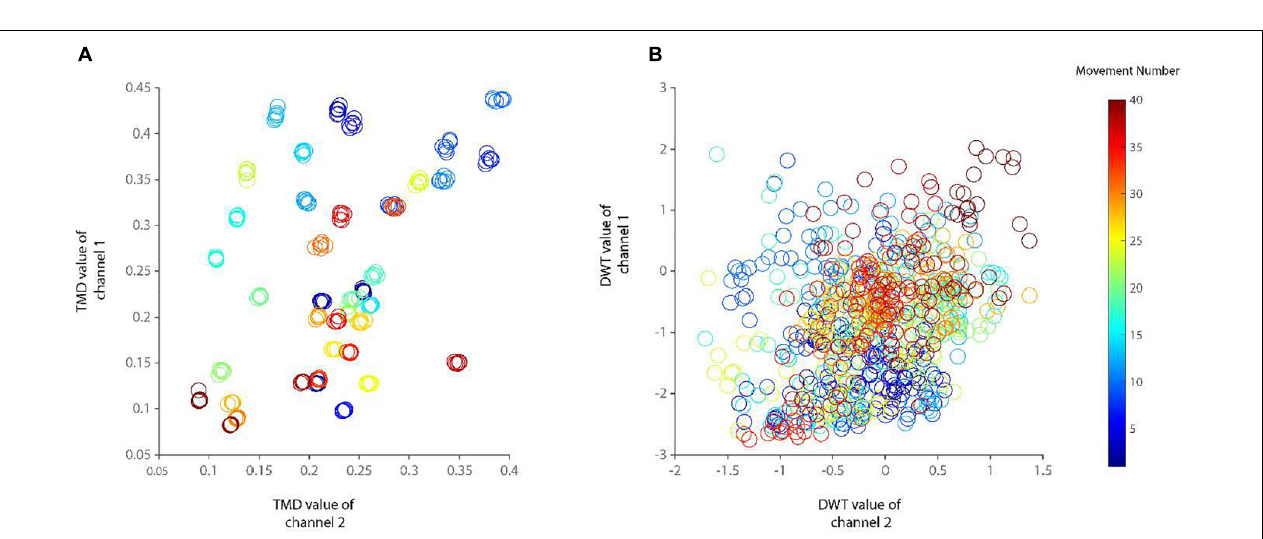
FIGURE 3 | The scatter plot of the features trimmed mean of density (TMD) (A) and discrete wavelet transform (DWT) (B) in the second versus first recording channels in a subject. Features related to a specific movement calculated at different recording data repetitions were grouped on the left panel. The color bar shows the colors assigned to each recording